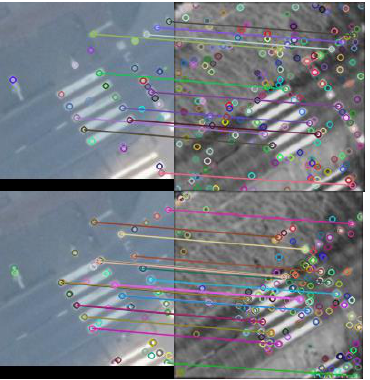
Figure 15 Comparison of SIFT (top) and KAZE (bottom) in 4 th run on 1 st scene.